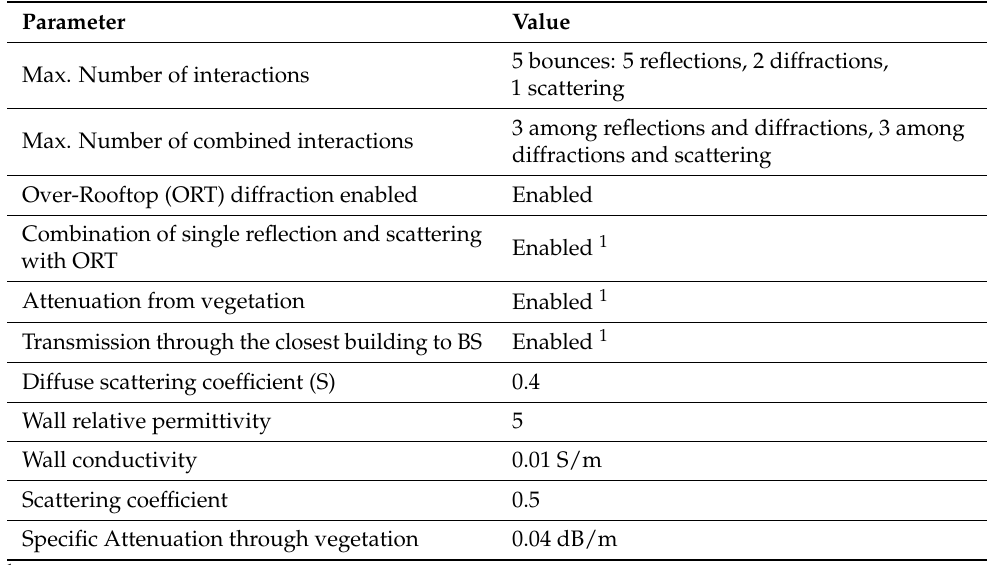
Table 1. Main settings for ray launching